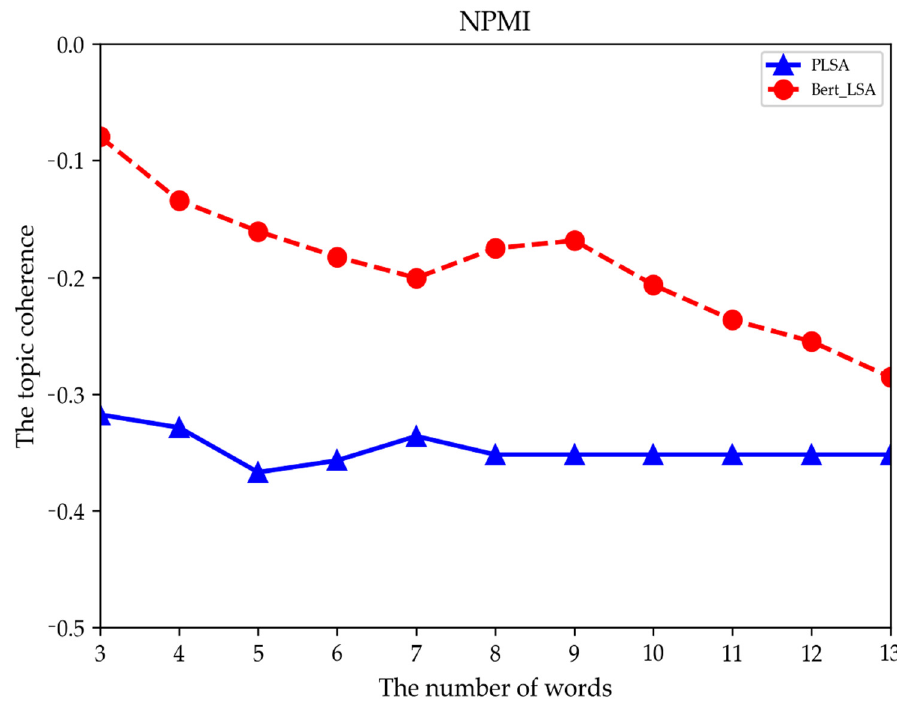
Figure 7. Topic consistency values of PLSA and Bert-LSA models obtained with the NPMI method.